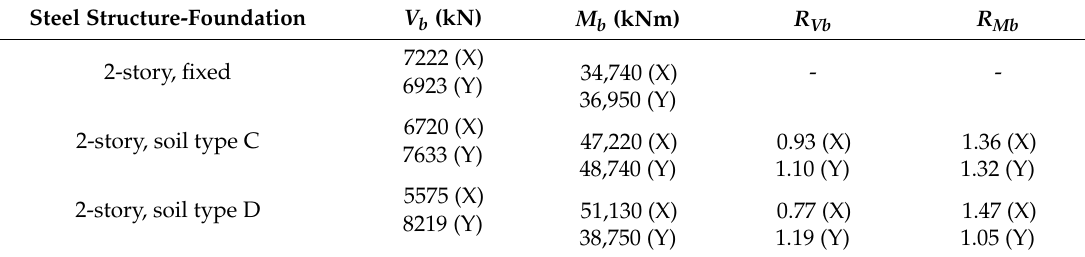
Table 7. Maximum V b , M b , and R values of the 2-story steel structure-foundation systems. Steel